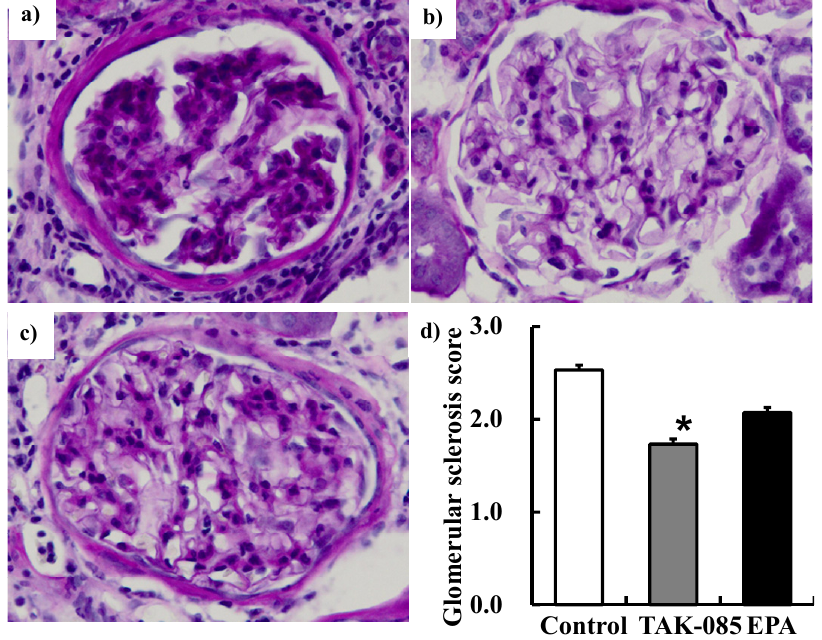
Figure 1. Photomicrographs of coronal sections of the glomeruli from ( a ) the control group, ( b ) the TAK-085-administered group, ( c ) and the EPA-administered group. ( d ) Glomerulosclerosis was semi-quantitatively evaluated. Values are presented as mean ± SE (n = 10–11). Statistical analysis was performed by one-way ANOVA followed by Dunnett’s test. * P < 0.05 vs. control